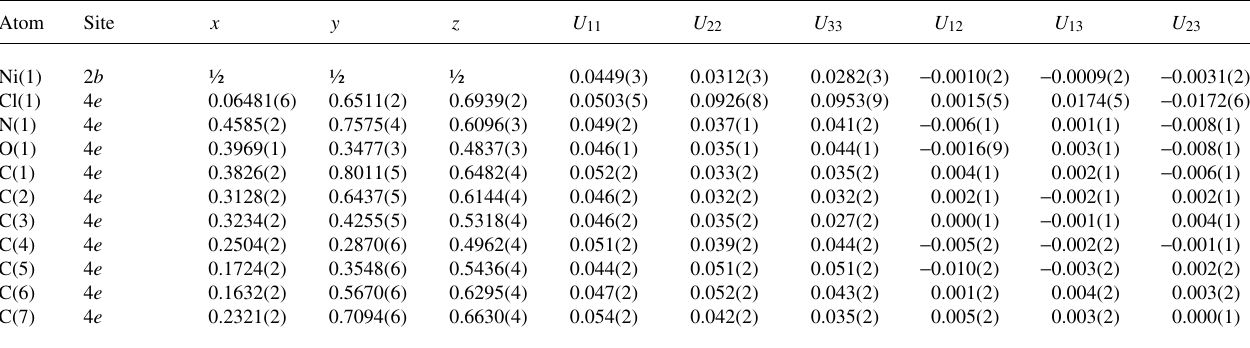
Table 3. Atomic coordinates and displacement parameters (in Å 2 )